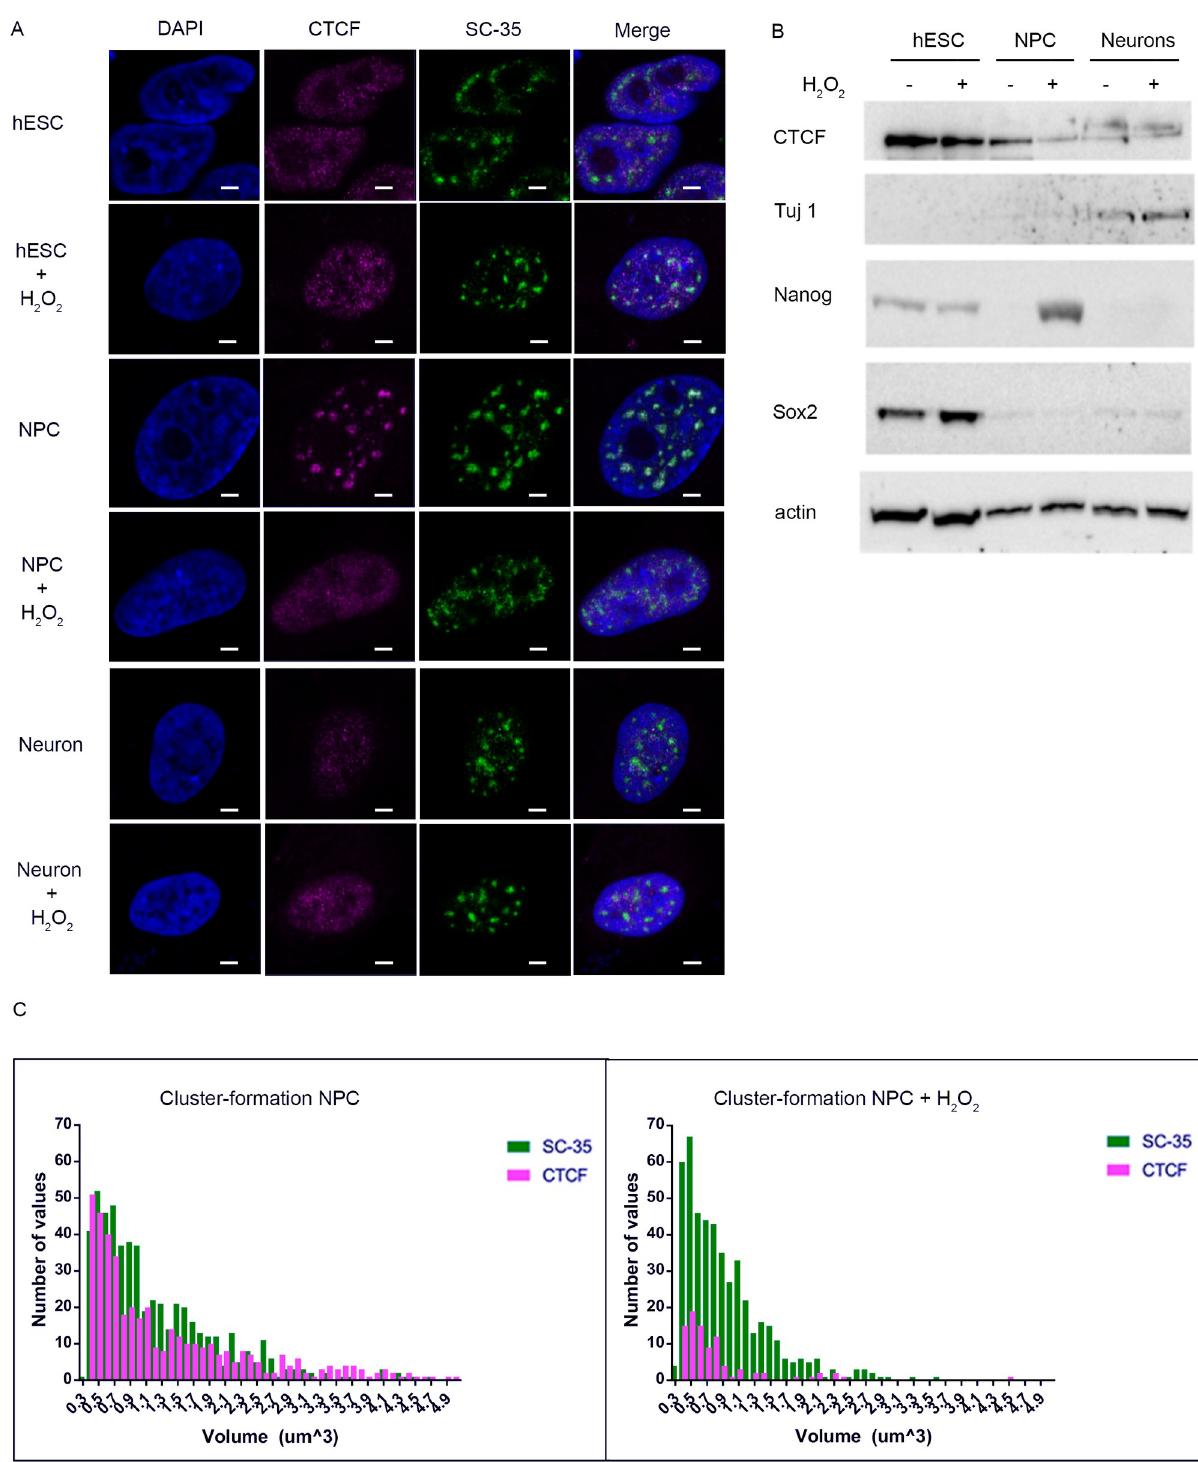
Fig 6. Stress-sensitive CTCF complexes at SC-35-associated nuclear speckles are exclusively found at the neural progenitor cells (NPCs) stage of neuro development. (A) hPSCs, NPCs, and early neurons were exposed to H 2 O 2 treatment and stained with anti-CTCF, anti-SC-35 and DAPI. Samples were visualized with an Airyscan microscope; (NPC: n = 21; NPC + H 2 O 2 : n = 21). (B) hPSCs, NPCs, and early neurons were exposed to H 2 O 2 treatment and CTCF protein levels were analyzed by Western blotting. Developmental markers for different neuronal stages are also shown. (C) Histograms demonstrate loss of CTCF cluster-formation (red) from NPCs to H 2 O 2 -treated NPCs, whereas the distribution of SC-35-associated clusters (green) remains relatively stable. https://doi.org/10.1371/journal.pgen.1009277.g006 PLOS Genetics | https://doi.org/10.1371/journal.pgen.1009277 January7, 2021 15 /